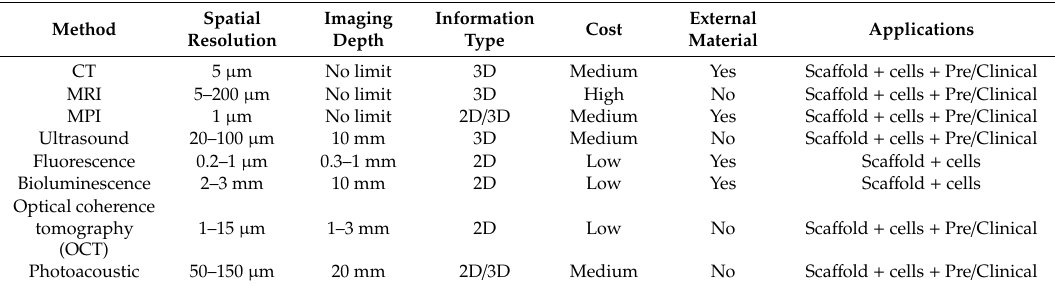
Table 1. List of non-invasive imaging methods, their resolution and depth, costs, external material usage, information type as well as applications in TE ranging from imaging sca ff olds (with or without cells), and preclinical and clinical applications.